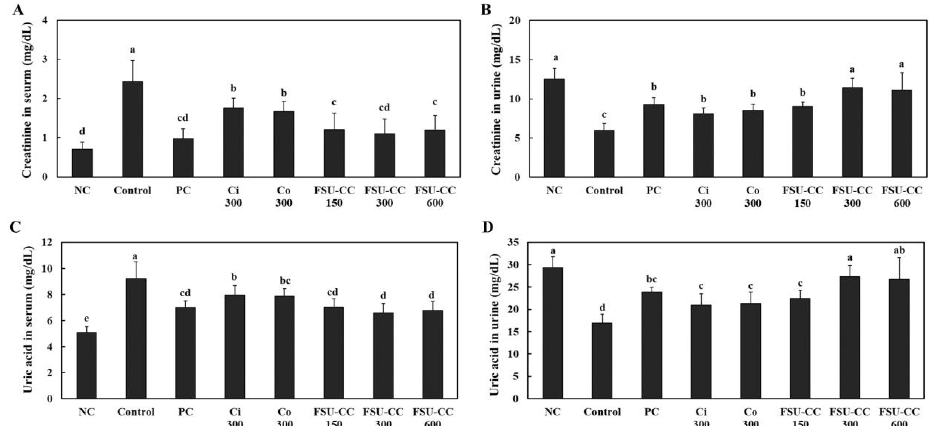
Figure 4. Levels of creatinine in serum ( A ) and urine ( B ) and uric acid in serum ( C ) and urine ( D ) in the hyperuricemia- induced mice supplemented with and without Ci, Co, or FSU-CC. NC: normal control, C: hyperuricemia-induced mice, PC: hyperuricemia-induced mice with oral supplementation of allopurinol 10 mg/kg b.w., Ci 300: hyperuricemia-induced mice with oral supplementation of C. indicum L. 300 mg/kg b.w., Co 300: hyperuricemia-induced mice with oral supple- mentation of C. officinalis Siebold and Zucc. 300 mg/kg b.w., FSU-CC 150: hyperuricemia-induced mice with oral supple- mentation of mixture of C. indicum L. and C. officinalis Siebold and Zucc. (1:2) 150 mg/kg b.w., FSU-CC 300: hyperuricemia- induced mice with oral supplementation of mixture of C. indicum L. and C. officinalis Siebold and Zucc. (1:2) 300 mg/kg b.w., FSU-CC 600: hyperuricemia-induced mice with oral supplementation of mixture of C. indicum L. and C. officinalis Siebold and Zucc. (1:2) 600 mg/kg b.w. Different letters indicate significant difference at p < 0.05, as determined by Duncan’s multiple range test.